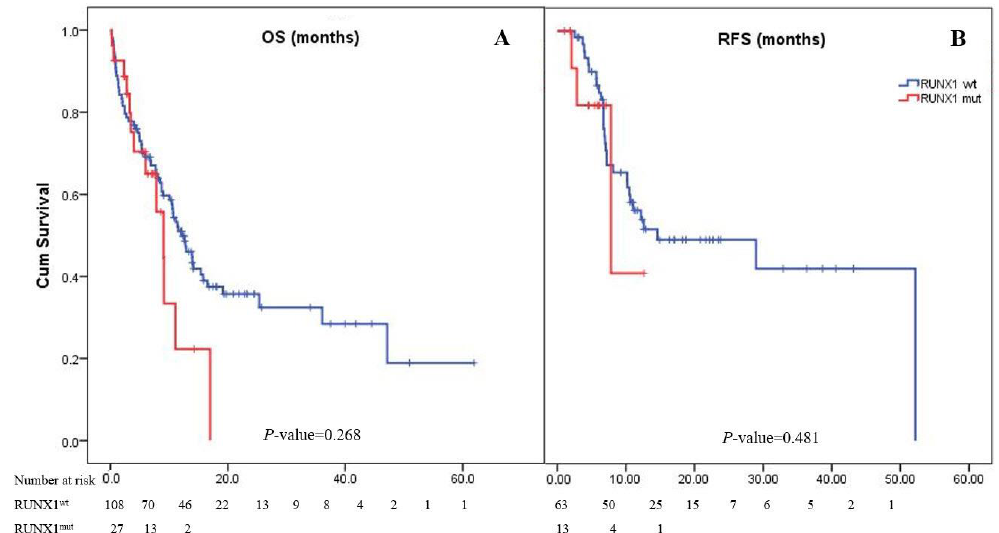
Figure 1. Kaplan–Meier curves of overall survival ( A ) and relapse-free survival ( B ). Panel A shows Kaplan–Meier curves for overall survival corresponding to the presence or absence of the RUNX1 mutation. The median overall survival of AML patients with RUNX1 mut was 9.1 months, while it was 12.9 months in patients with RUNX1 wt ( p = 0.268). Panel B shows Kaplan–Meier curves for relapse-free survival as assessed by the investigator. The median relapse-free survival was 7.8